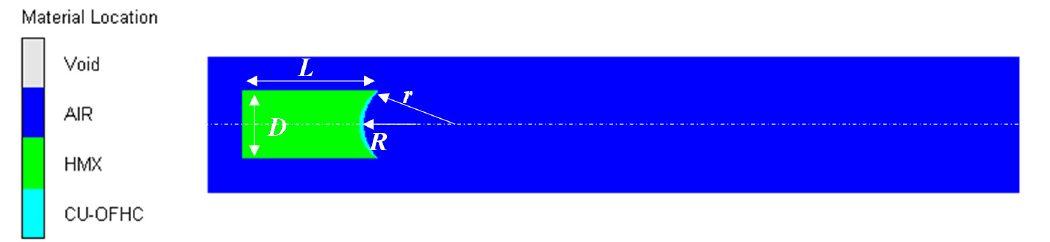
Figure 2. Numerical model of the air explosion of the shaped charge.